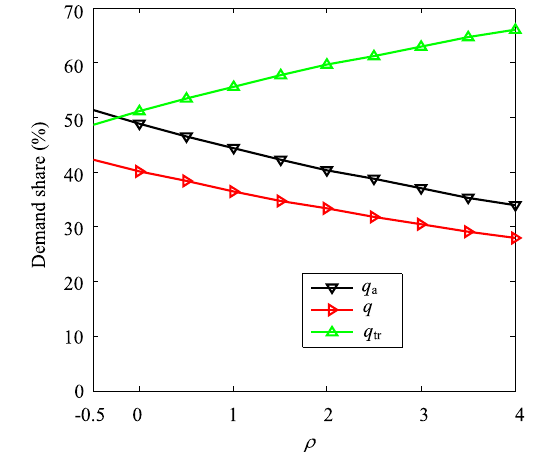
Fig. 8 T C for different q ( k = 0.7897)